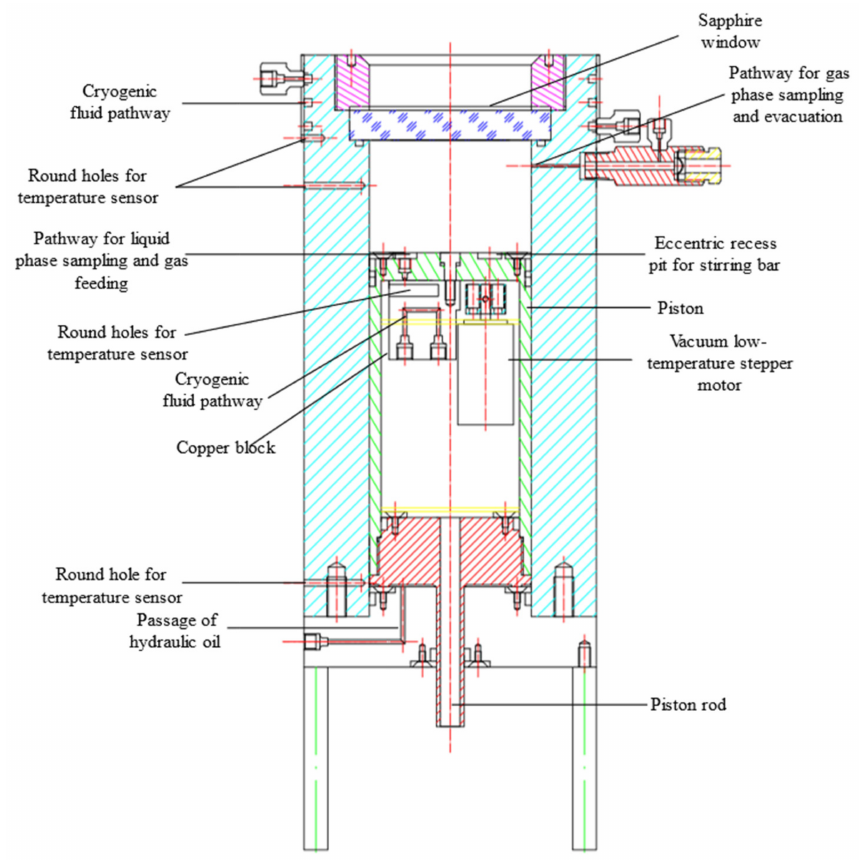
Figure 4. Reaction kettle schematic diagram.